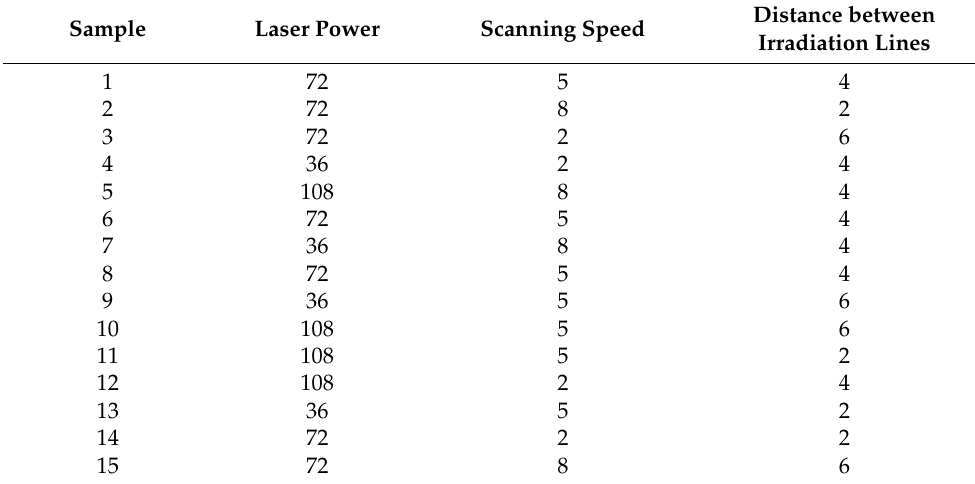
Table 2. Executed experiments for LFP of cylindrical